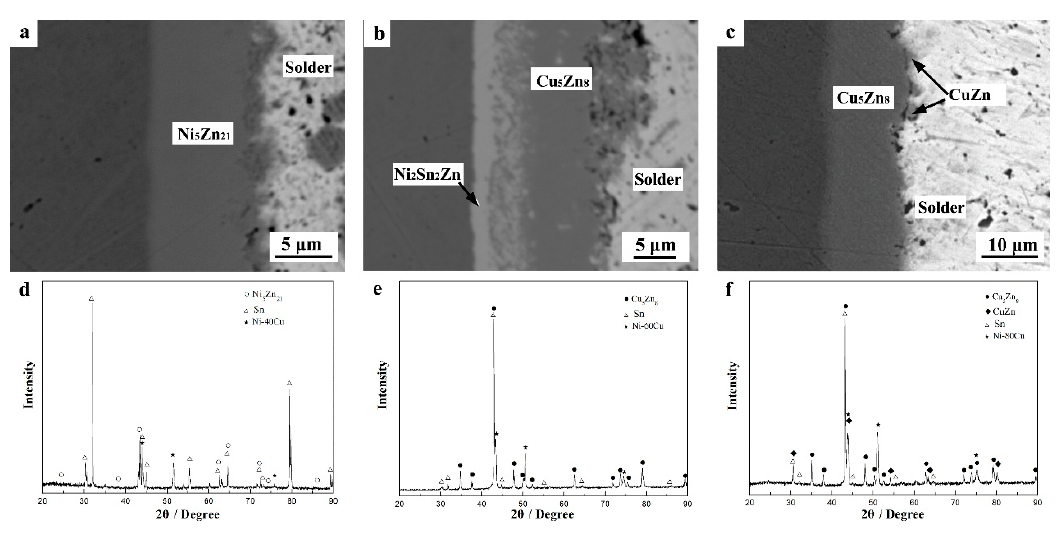
Figure 5. Cross-section micrographs and X-ray diffraction (XRD) patterns of etched interface of joints after soldered 9 h at 250 ◦ C: ( a , d ) Sn-Zn / Ni-40Cu; ( b , e ) Sn-Zn / Ni-60Cu; ( c , f ) Sn-Zn / Ni-80Cu. Table 2. The composition of reaction products in Sn-Zn / Ni-Cu joints after soldered at 250 ◦ C for 9 h. Compositions (at.%) Substrate Phase Ni Cu Sn Zn